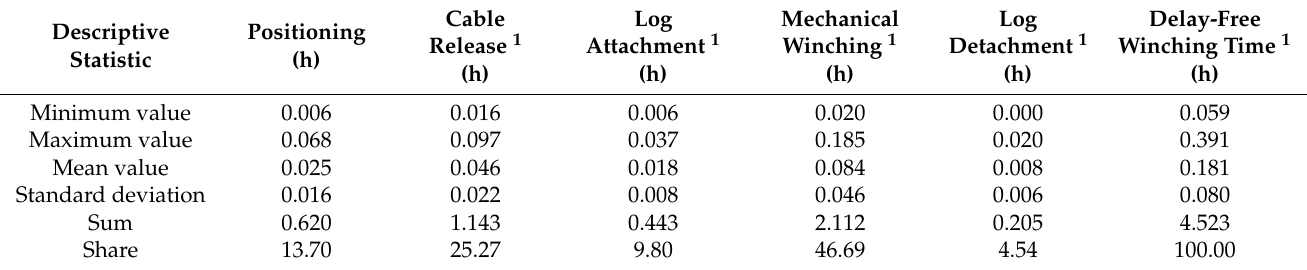
Table 3. Statistics of elemental time consumption within a delay-free winching work